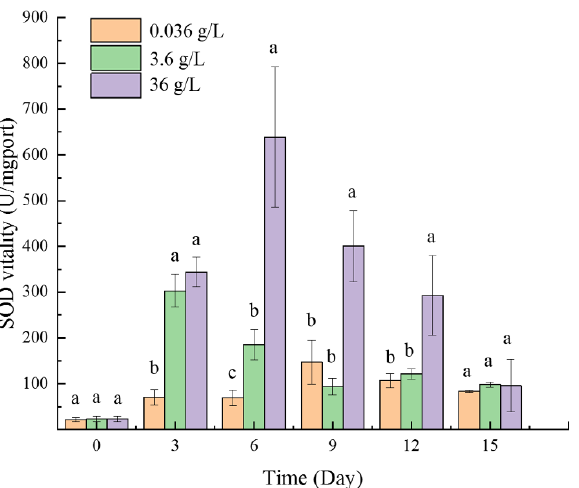
Figure 4. Effects of three concentrations of CaCl 2 on the superoxide dismutase (SOD) activity of P. kessleri FACHB-3316 (The letters a and b indicate the significance of the difference).